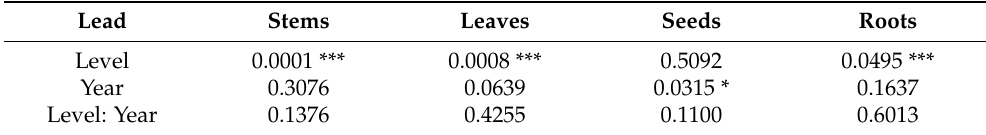
Figure 4. Concentration of Pb ( μ g g − 1 ) in the different fractions of the plant as average of two years. The multiple comparison between the means has been performed within the plant fractions. Values with different letters indicate statistical significance (according to HSD at p ≤ 0.05). Table 6. Two-way ANOVA of the main factor and interaction for the concentration of lead in stems, leaves, seeds, and roots during the two years of the experiment (* significance level at p ≤ 0.05, *** significance level at p ≤ 0.001).